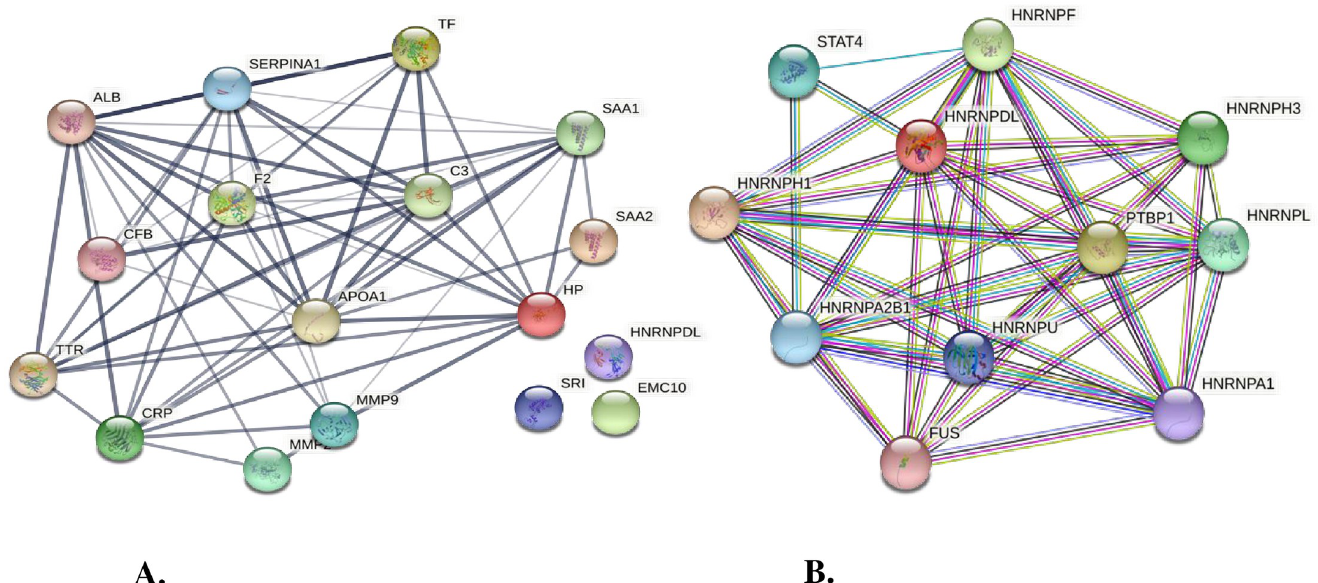
Fig 5. STRING interaction network depicts the association among the differentially regulated proteins. Color balls are representing individual proteins and lines represent their interactions: (A) Interaction of differentially expressed proteins and (B) hnRNP-D interactions with different proteins.